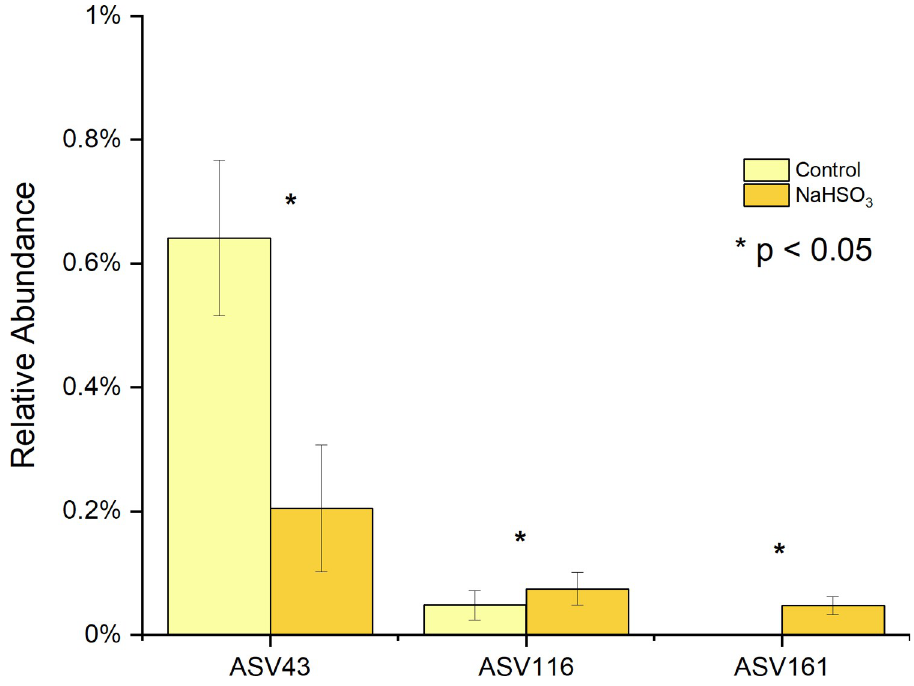
Fig 7. Differentially abundant ASVs in F2 sample after NaHSO 3 treatment at time 0. ASV43 shows a significant decrease while ASV116 and ASV161 increased significantly after the